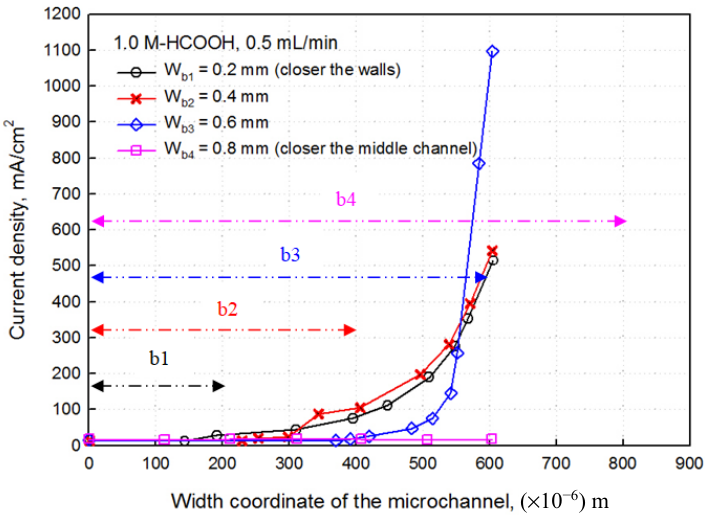
Figure 7. The local current density distribution on the anode surface with four different sizes of blunt object in the channel performed on 0.5 mL/min with inlet 1.0 M-HCOOH.